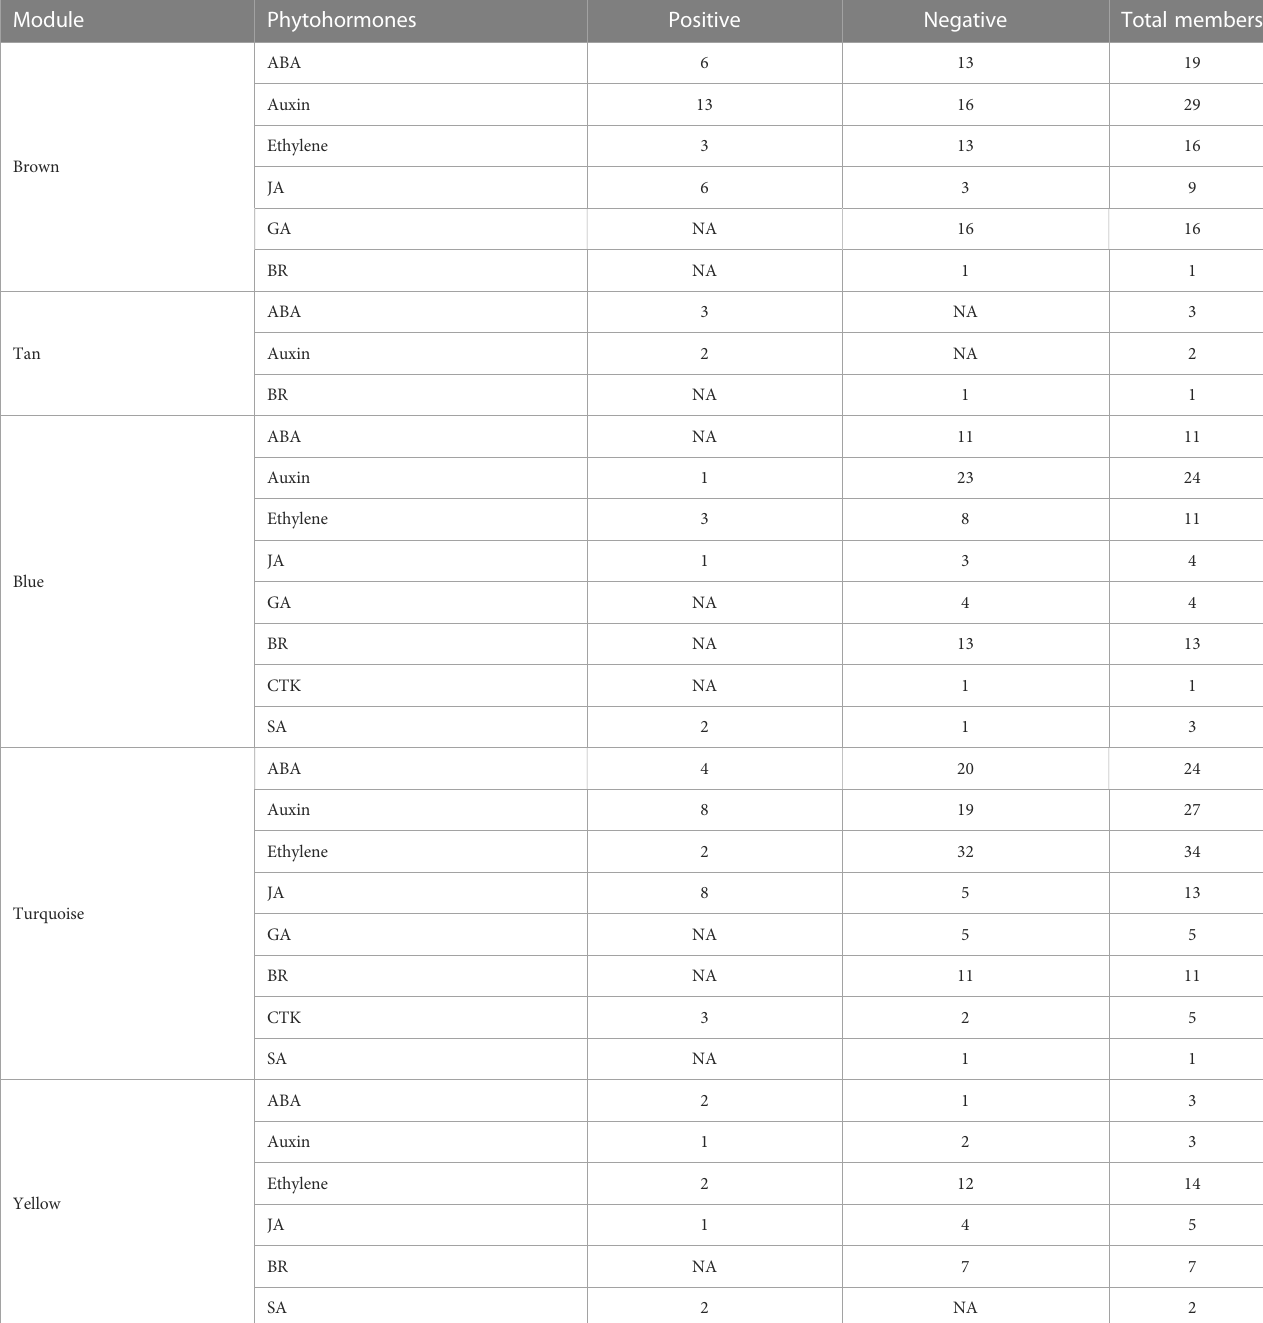
TABLE 1 The list of isoforms associated with phytohormone signaling in fi ve modules. Module